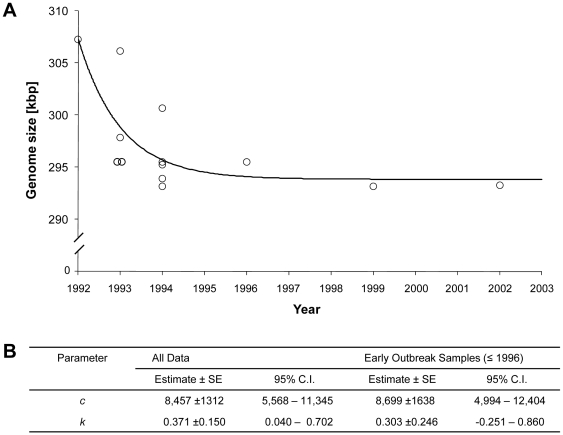
Dynamics of WSSV genome shrinkage.Panel A: the year of first outbreak for the country a WSSV isolate was collected from is plotted on the x-axis, and the genome size in kpb is plotted on the y-axis. The circles are data points, whereas the line indicates the model fitted to all the data (equation 2). Panel B: results of model fitting, for all data or only the early outbreak data. The standard errors (SE) and confidence intervals (C.I.) of parameter estimates are given. In both analyses, k is significantly smaller than 1 as predicted by a geometric model of adaptation, where each new deletion occurring is smaller than the previous deletion.